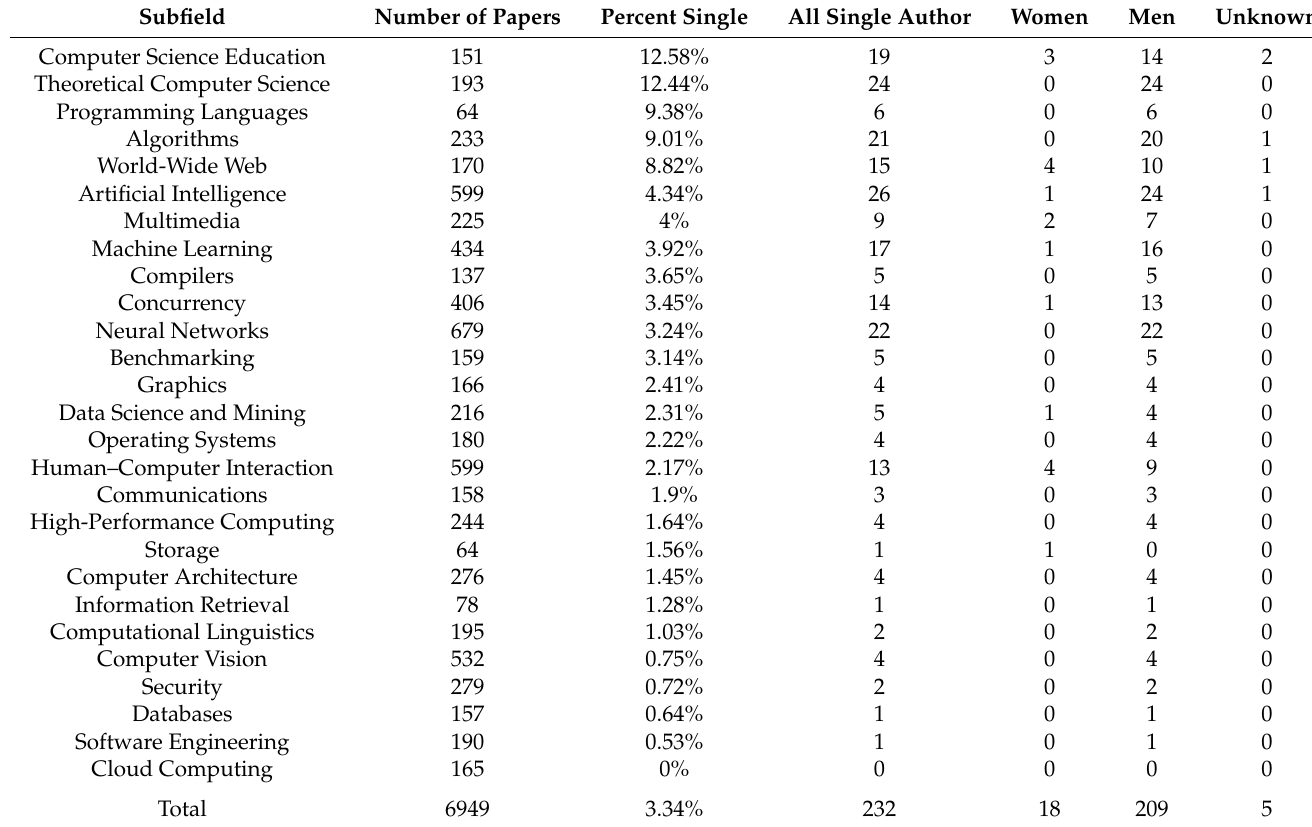
Table 3. Number of papers by subfield and gender, sorted by the overall percentage of single-author